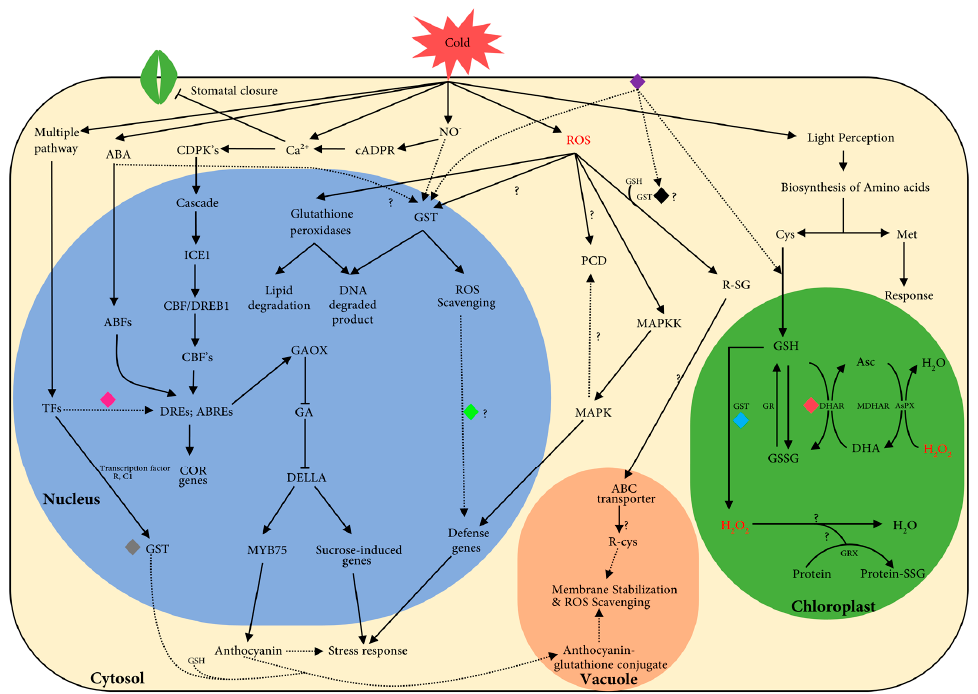
Figure 6. Simplified overview of GST genes involved in cold pathway, colored diamond shape represents the possible role of different GST classes as mentioned in Table 4. Potential deleterious compound are shown in red color, black solid arrow indicates proven experimental evidence available in literature, black dotted arrow indicates possible predicted function based on localization and protein–protein interaction and the question mark indicates the unknown cellular reaction during cold stress. Role of GSH: photosystem in light perception are proposed pathways for GST genes during cold stress. TFs, transcription factor; Transcription factor R bHLH family; C1, R2R3-MYB protein family; ABA, abscisic acid; ABRE, abscisic acid responsive element; COR, cold responsive element; NO − , nitric oxide; cADPR, cyclic adenosine triphosphate ribose; Ca 2+ , calcium ion signal; CDPK, calcium dependent protein kinases; ICE1, inducer of CBF expression 1; CBF/DREB1, C-repeat binding factor/dehydration responsive-element binding; DRE, dehydration responsive element; GAOX, gibberellic acid oxidase; GA, gibberellic acid; MYB, myeloblastic transcription factor; ROS, reactive oxygen species; GST, glutathione transferase; PCD, programmed cell death; R-SG, conjugated compound with GSH; MAPK, mitogen-activated protein kinase; MAPKK, MAPK kinase; Cys, cysteine; Met, methionine; GSH, glutathione; GSSG, reduced glutathione; DHAR, dehydroascorbate reductase; DHA, dehydroascorbate; MDHAR- mono dehydroascorbate reductase; Asc, ascorbate; AsPX, ascorbate peroxidase; H 2 O 2 , hydrogen peroxide; GR, glutathione reductase; GRX, glutaredoxin.